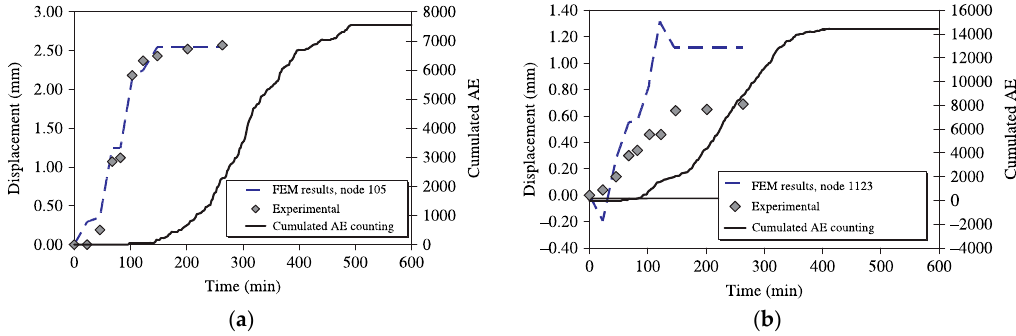
Figure 9. Graph of the comparison between cumulated acoustic emission (AE) counting (right y ‐ axis), and the experimental or two ‐ dimensional finite element vertical displacements (left y ‐ axis): ( a ) node 105, and ( b ) node 1123.